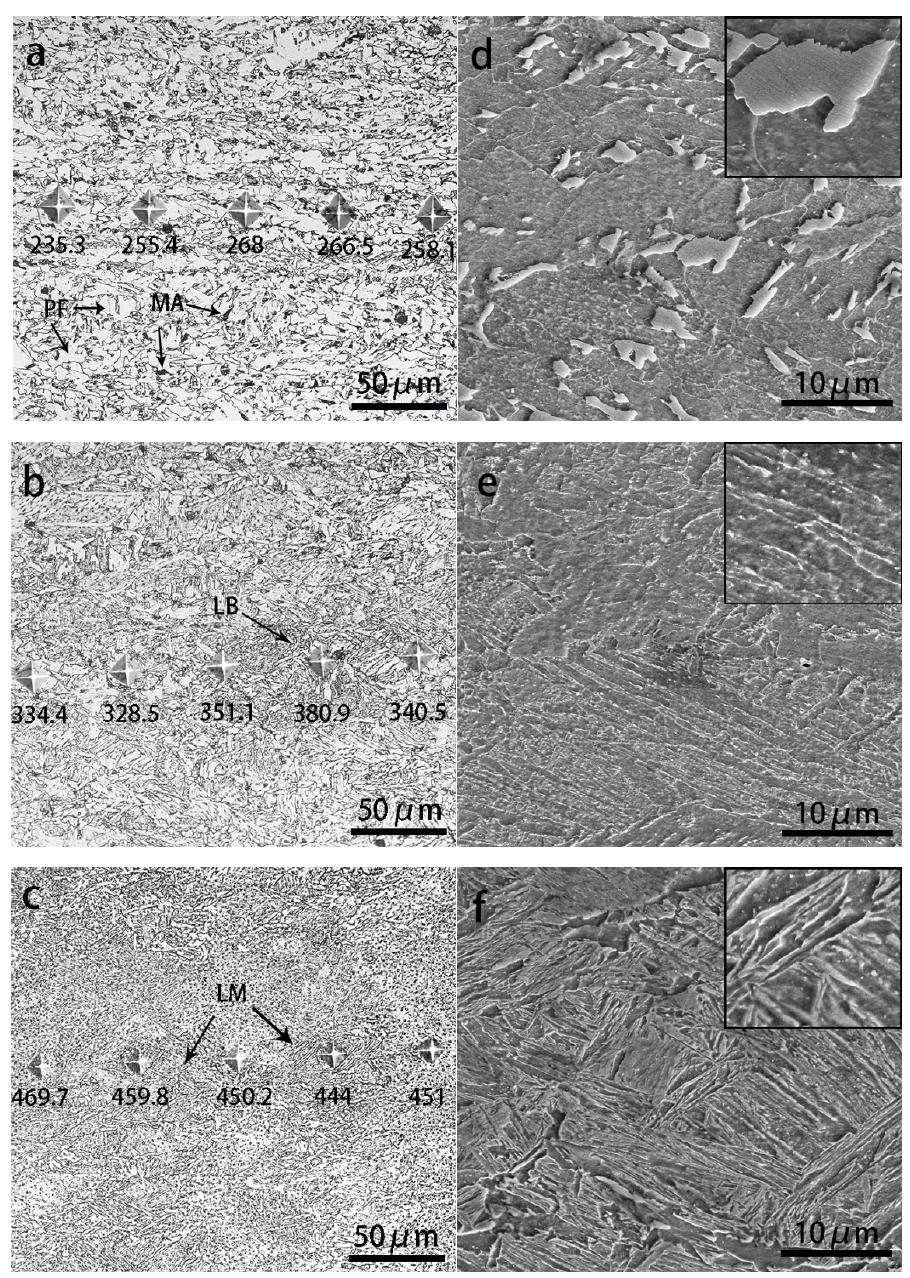
Figure 5. Microstructure in the segregated region as seen through an optical microscope and a scanning electron microscope: ( a ) And ( d ) for sample B-4#; ( b ) and ( e ) for sample A-4#; ( c ) and ( f ) for sample A-2#.